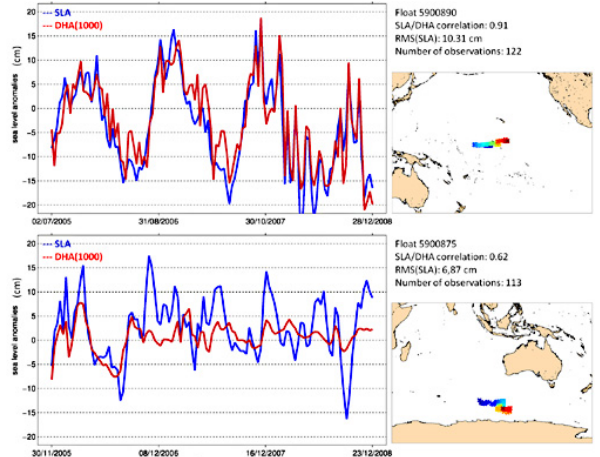
Fig. 2. DHA and collocated SLA for two Argo floats. The position of each float are also indicated, the blue cross corresponding to the deployment position, and the red cross to its last position.